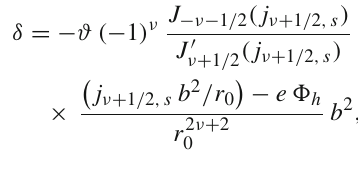
ent values of black hole charge, mirror radius and modes respectively, shows the change of the time scale with respect to b 2 . The values of the parametersinthegrapharechosensuchthatthesuperradiancecondition is